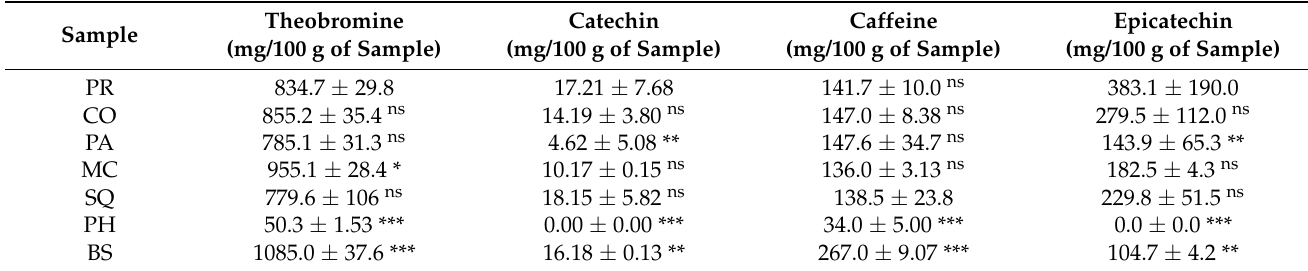
Table 1. Catechins and methylxanthines contents measured by HPLC-DAD-FLD.